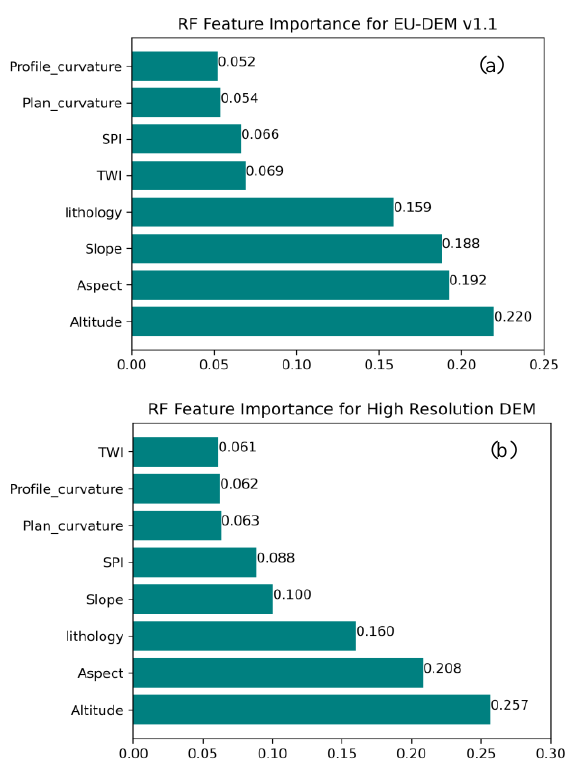
Figure 4 . Feature importance plots obtained from the RF for both